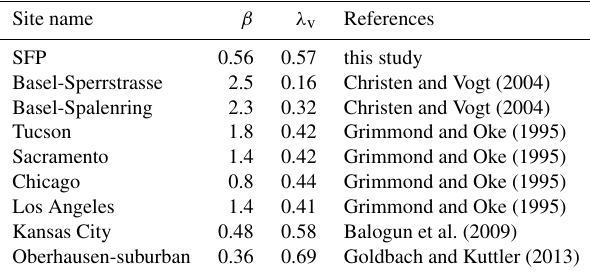
Table 2. Daytime Bowen ratio ( β = Q H /Q E ) in summer at the SFP and other urban sites with vegetation cover fraction ( λ v